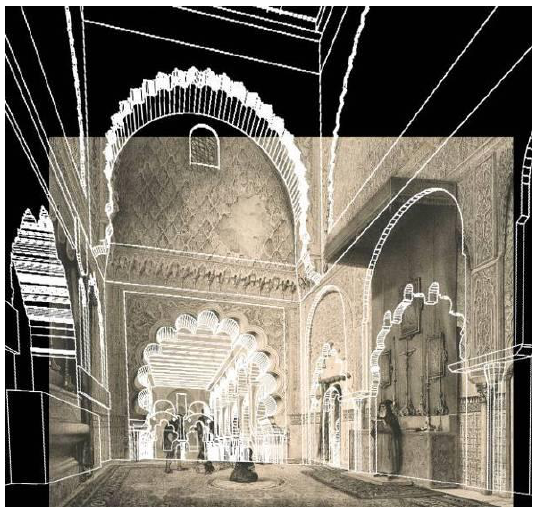
Figure 24. Girault de Prangey (1839). Digital model overlapping the Royal Chapel. Source: Own production.